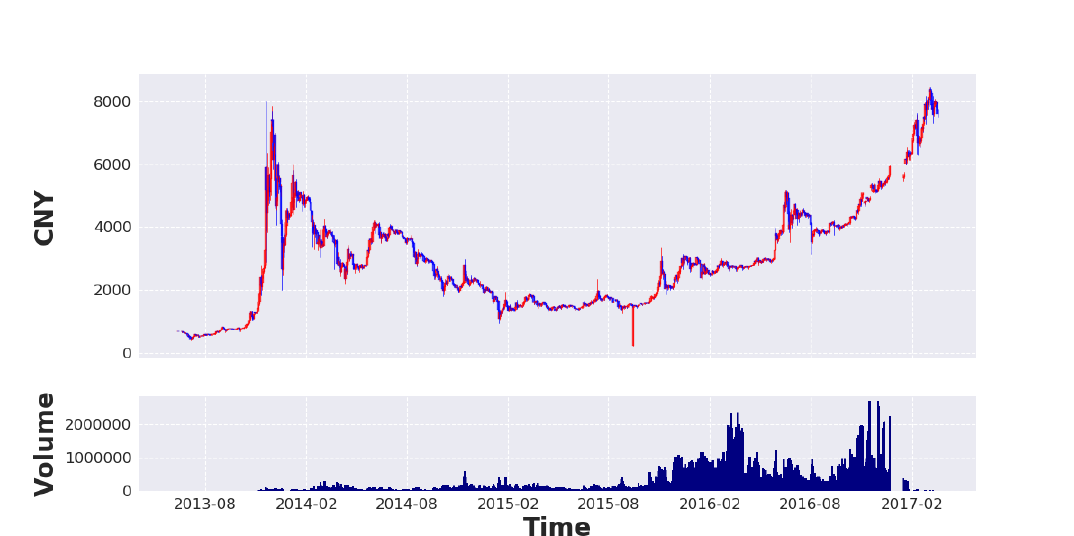
Figure 3. OHLC plot (Bitcoin price in CNY). The price peaks at the end of 2013 and gradually decreases toward the middle of 2015. Then, it recovers and peaks at the beginning of 2017. The price forms a u-shape in the long run. Note that the price highly fluctuates at the beginning of 2017 when Bitcoin markets were regulated in China. This caused class imbalance in the testing dataset (Figure 6).